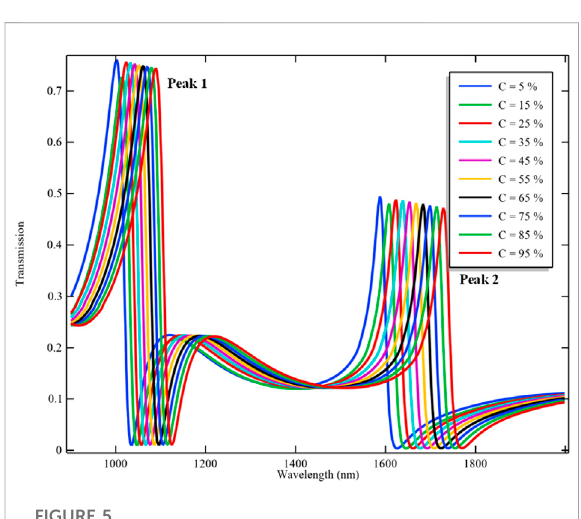
FIGURE 5 Transmission lines of different concentrations of glycerol.